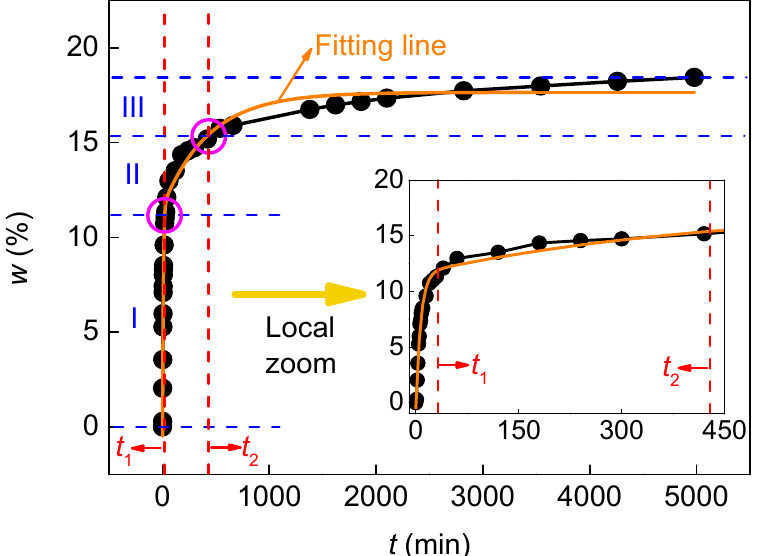
Figure 4. Changes in water content w with time t .